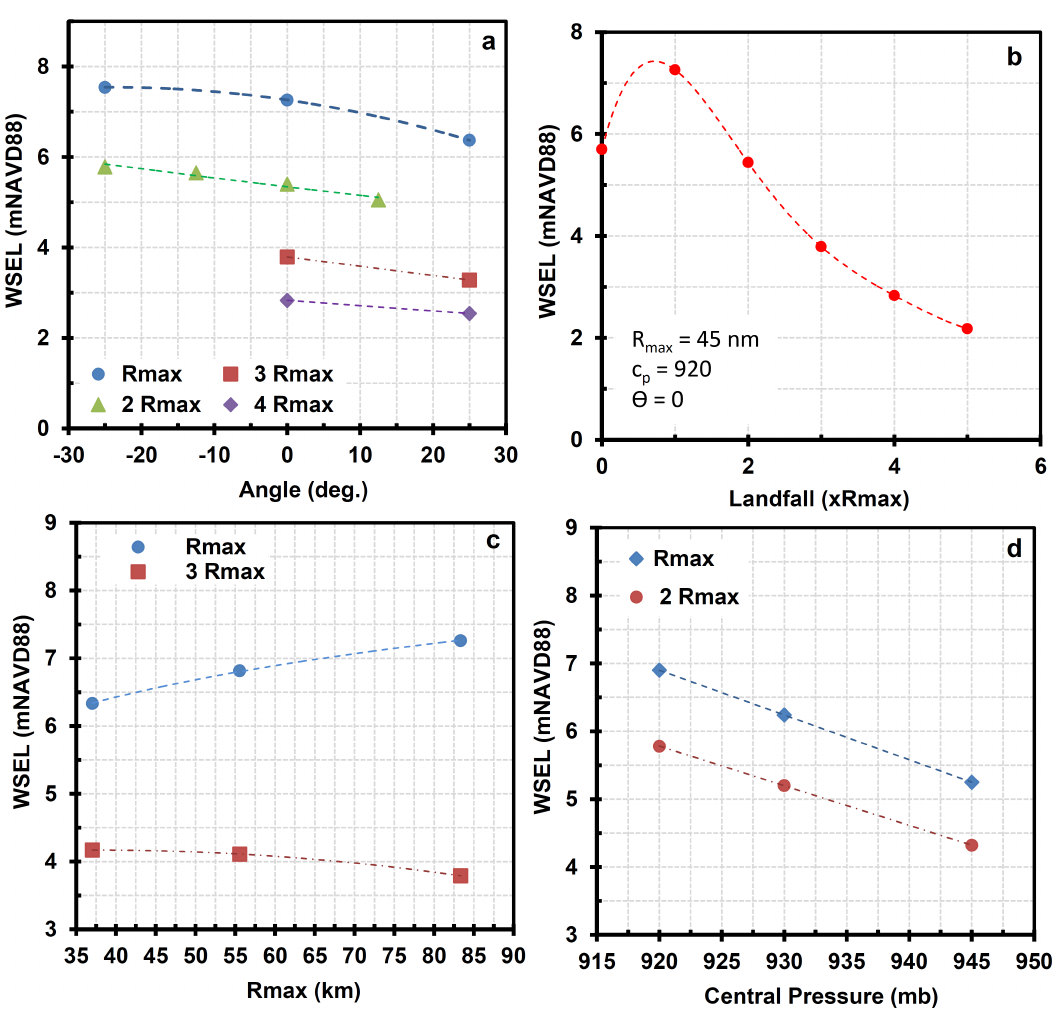
Figure 12. Relationship between major hurricane parameters including central pressure, radius of maximum wind, landfall location, and orientation with water surface elevation (WSEL) at the area of interest (AOI). The legend of ( a , c , d ) shows the closest distance between the AOI and synthetic hurricane track normalized with Rmax. Same applies to horizontal axis of ( b